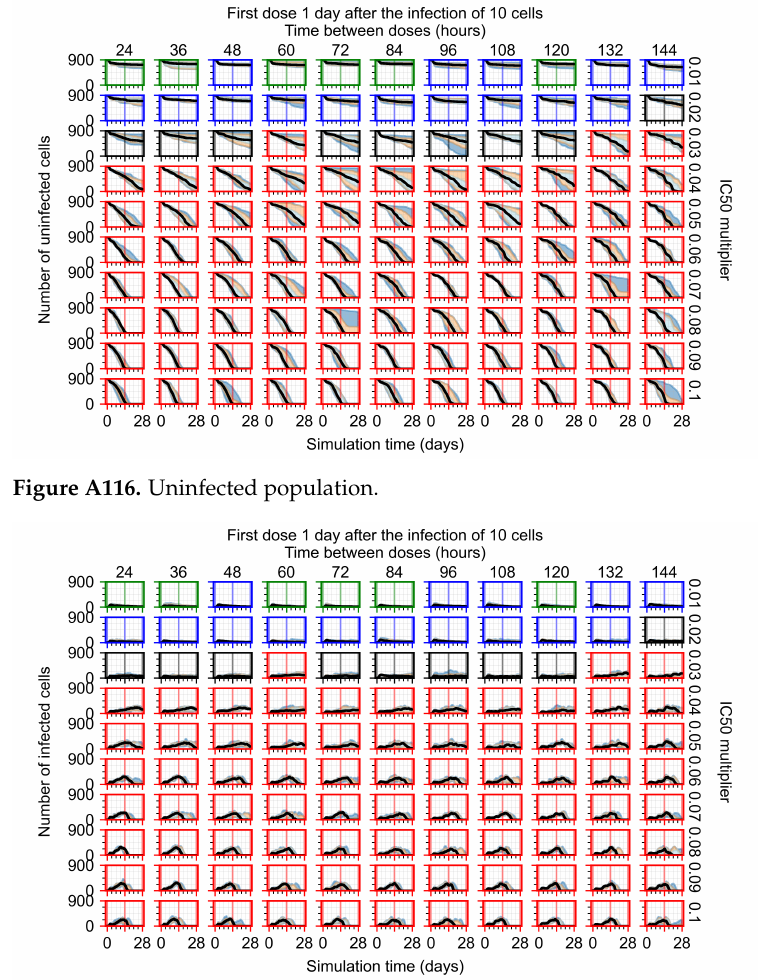
Figure A117. Infected (eclipse phase) population.